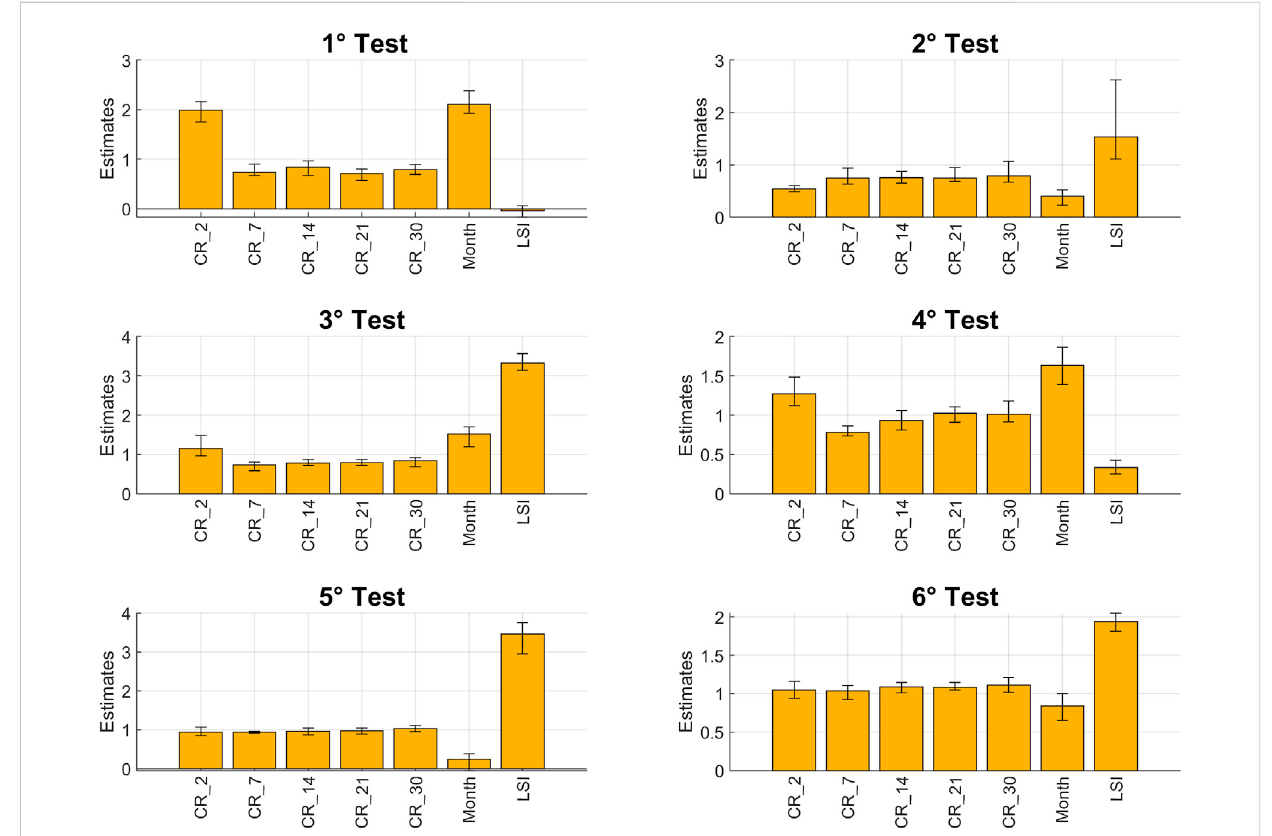
FIGURE 7 Histograms of OOB Permuted Predictions Importance Estimates for the fourth con fi